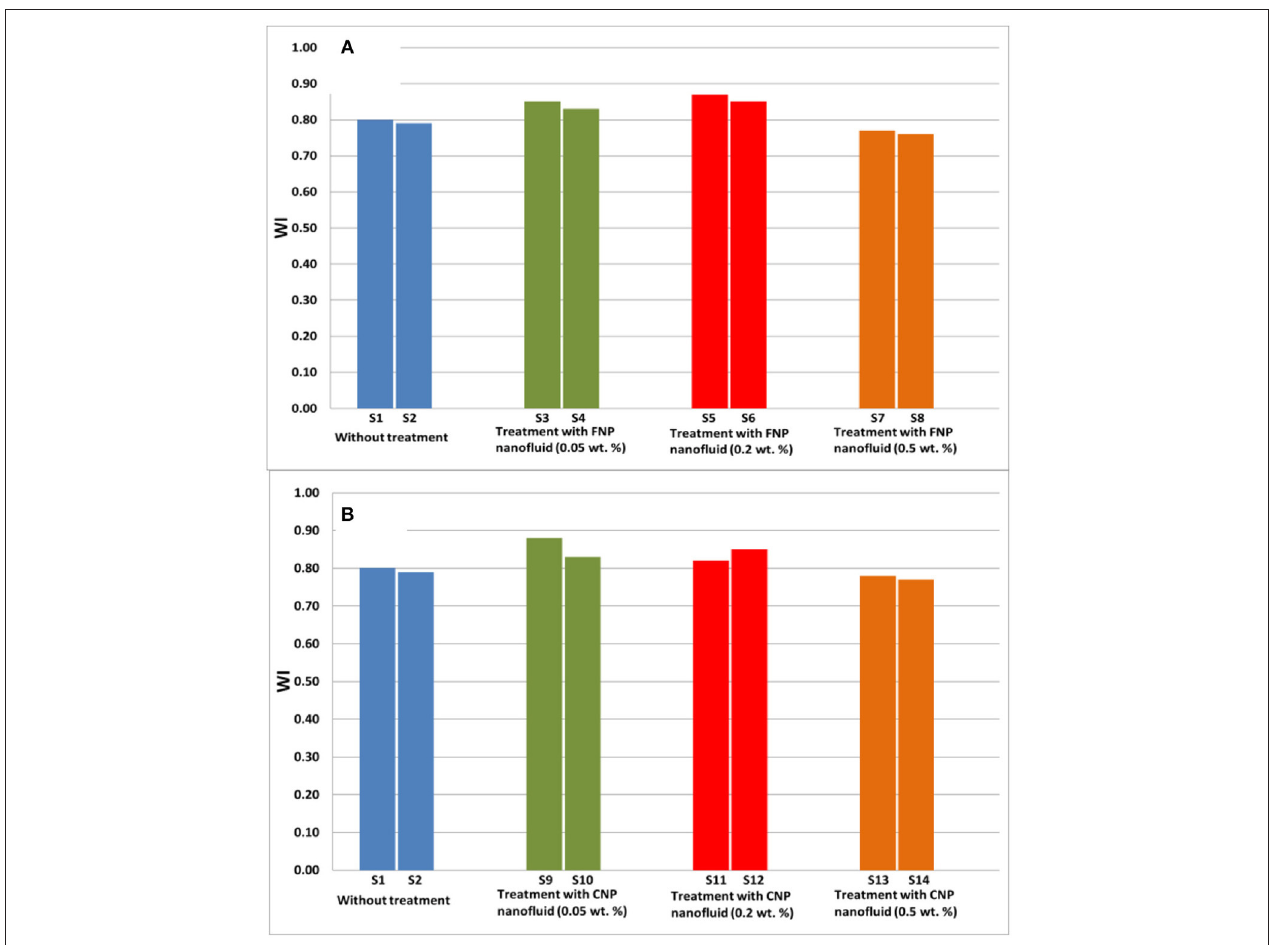
FIGURE 7 | Wettability Index: (A) core plugs treated with FNP; (B) core plugs treated with CNP.